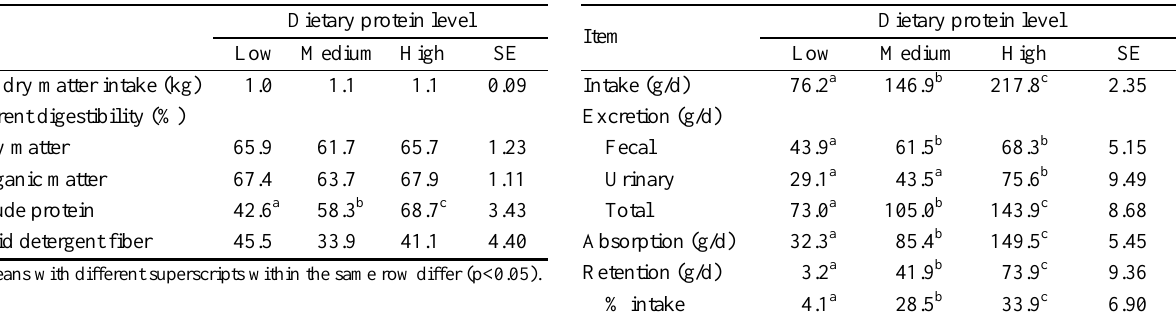
Table 2. Daily dry matter intake and apparent nutrient digestibility of diets with different levels (approximately 7%, 12%, and 17%) of crude protein fed to female spotted deer